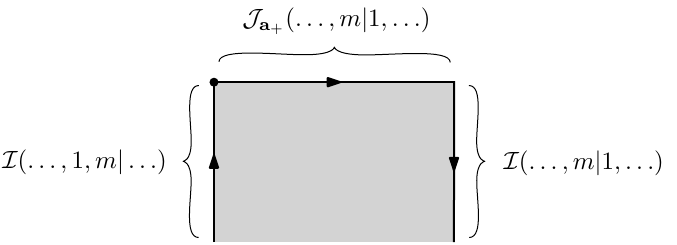
Figure 10 . Contours that produce graphs where particles 1 and m are adjacent in the field theory limit and which have mutually consistent definition of the loop momentum. Three more contours are on the lower side of the